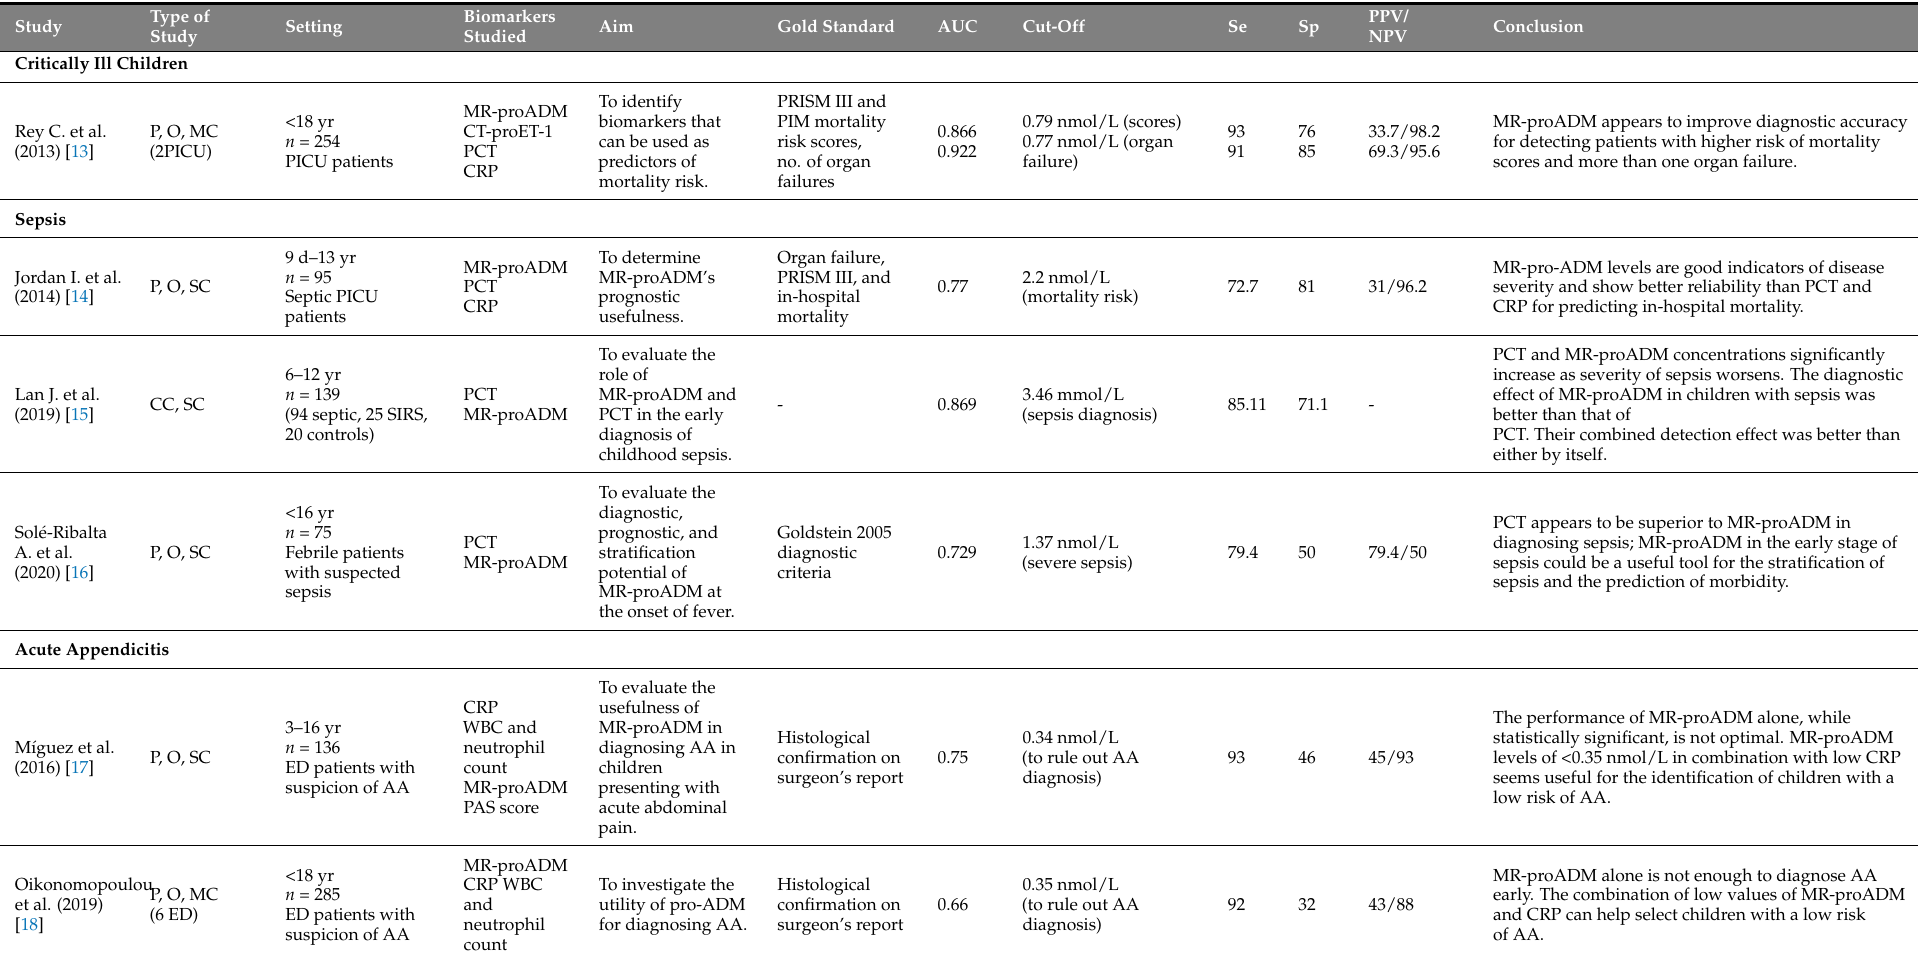
Table 1. Adrenomedullin in critically ill children and in paediatric